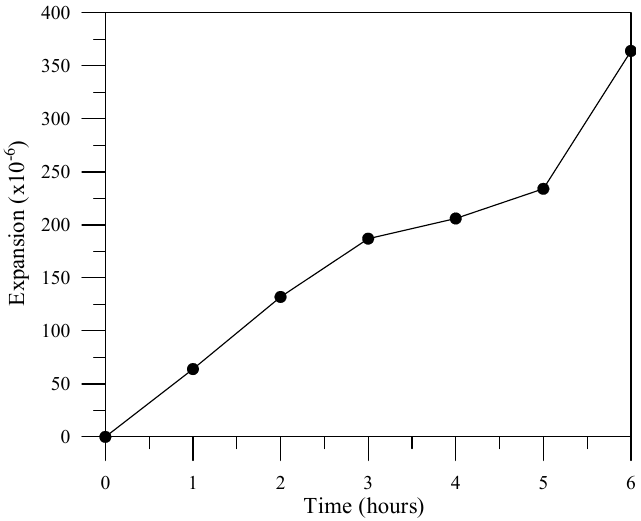
Figure 6. Expansion curve (prior to hardening).